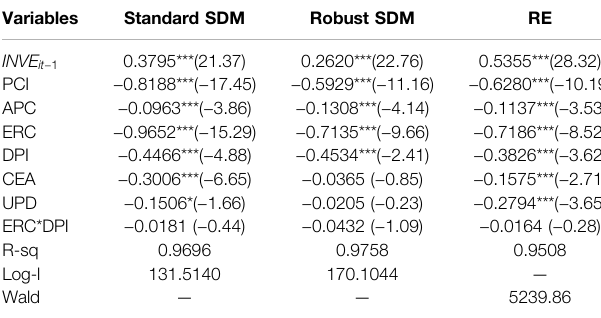
TABLE 14 | Robustness tests